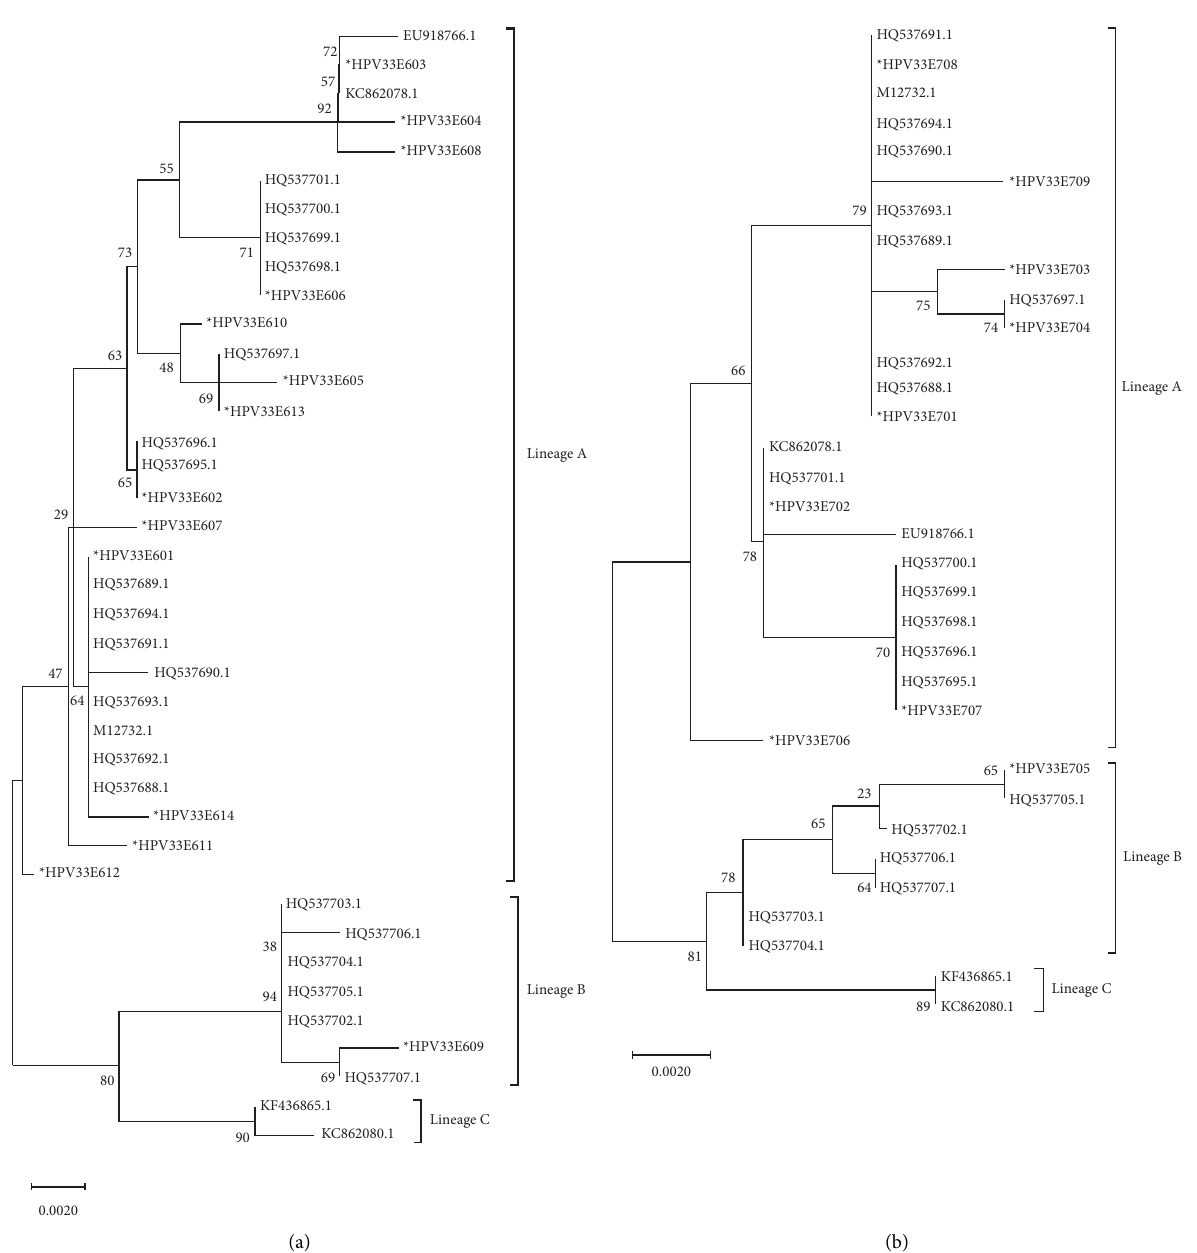
Figure 6: (a) Te neighbor-joining tree of HPV33E6. (b) Te neighbor-joining tree of